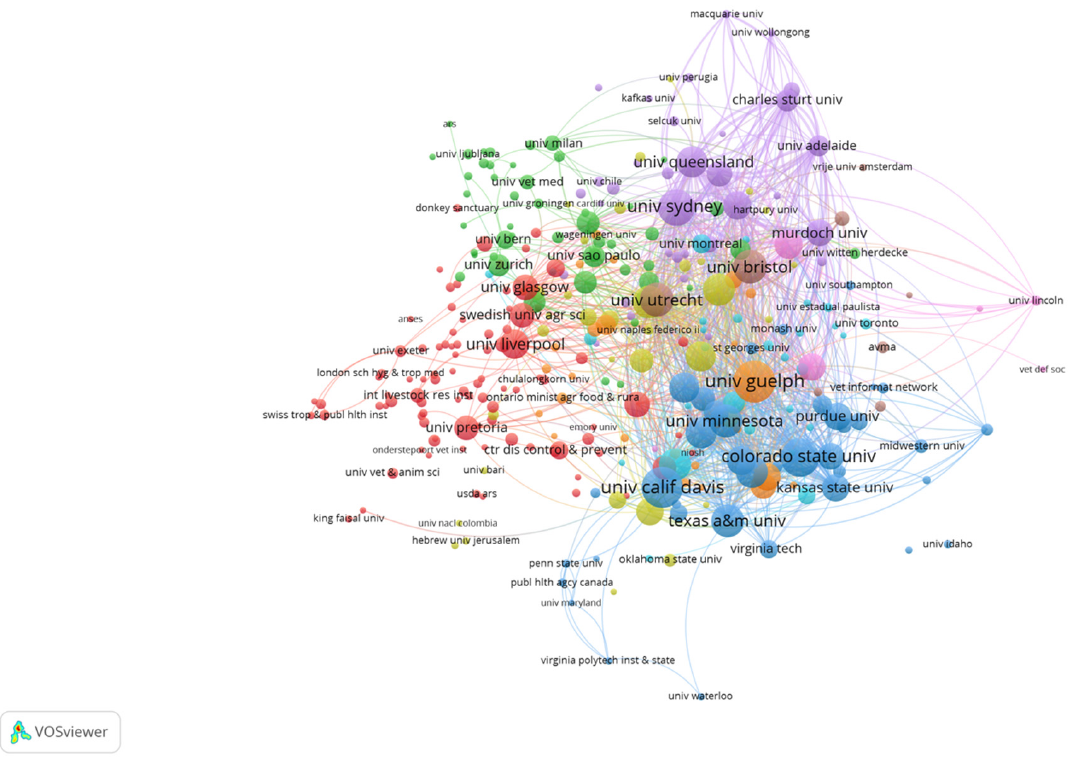
Figure 4. Institutional collaboration analysis of 6006 veterinary education publications (VEPs) from 2000 to 2021.